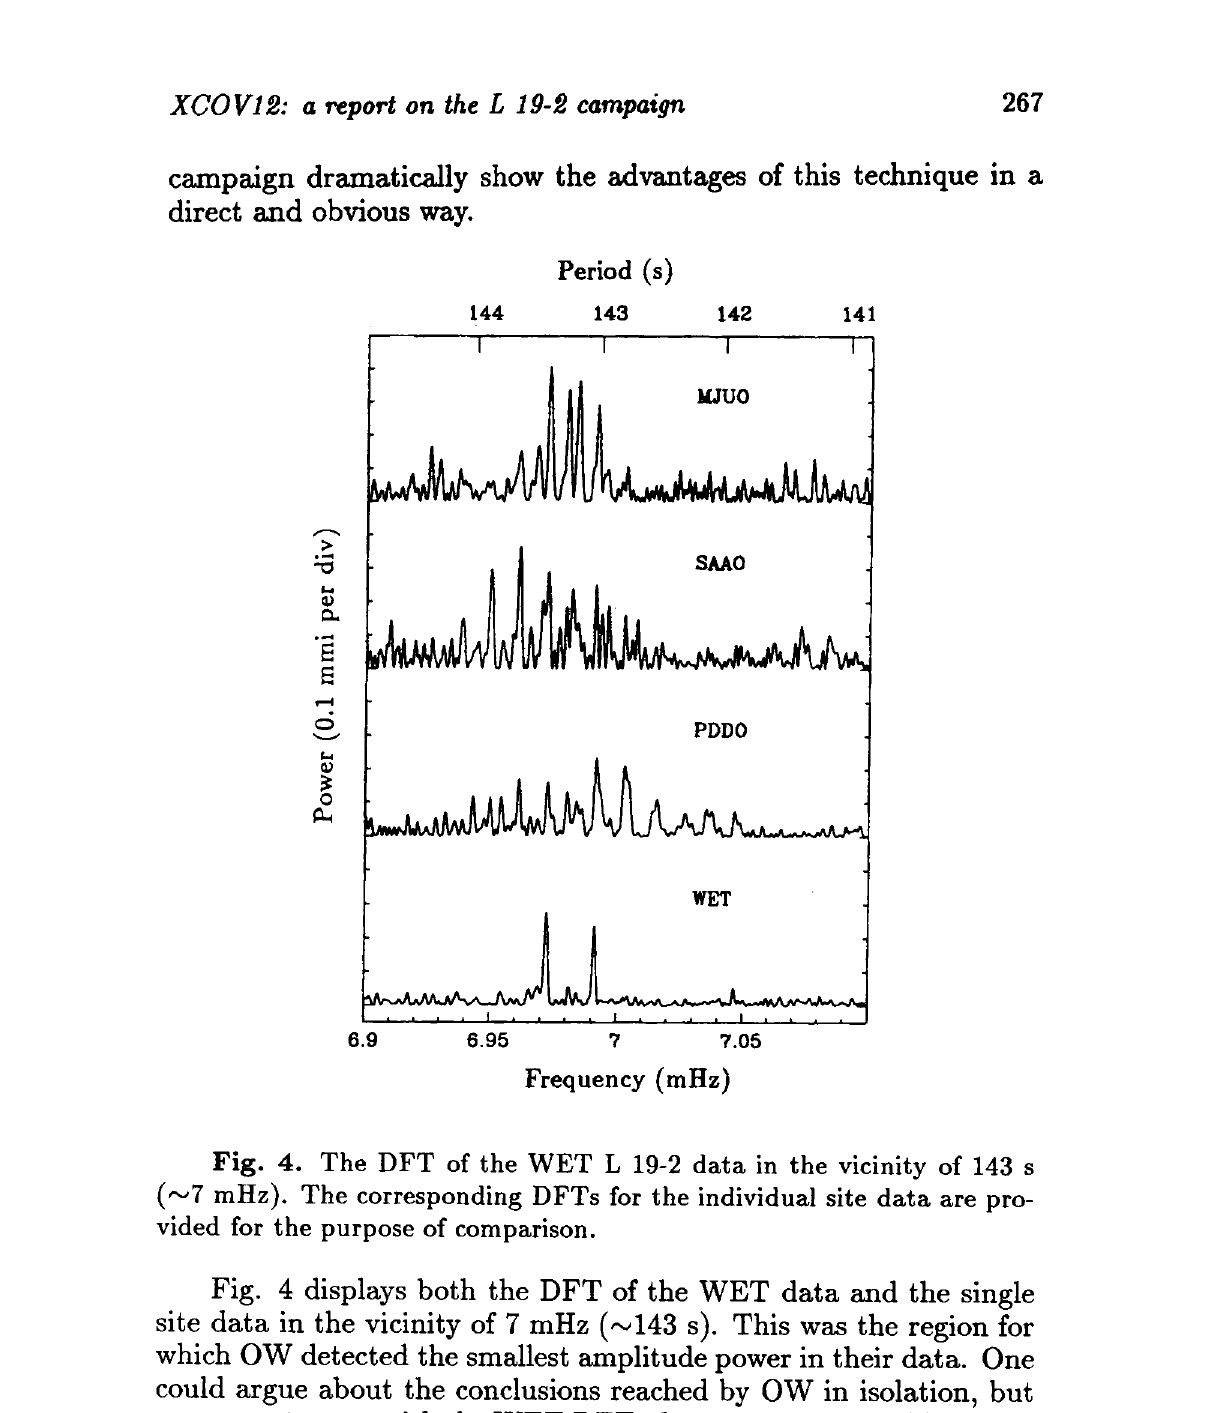
Fig. 4. The DFT of the WET L 19-2 data in the vicinity of 143 s ( ~7 mHz). The corresponding DFTs for the individual site data are pro- vided for the purpose of